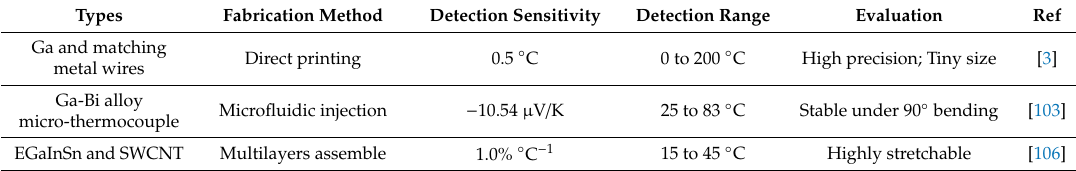
Table 3. Summary of temperature sensors based on liquid